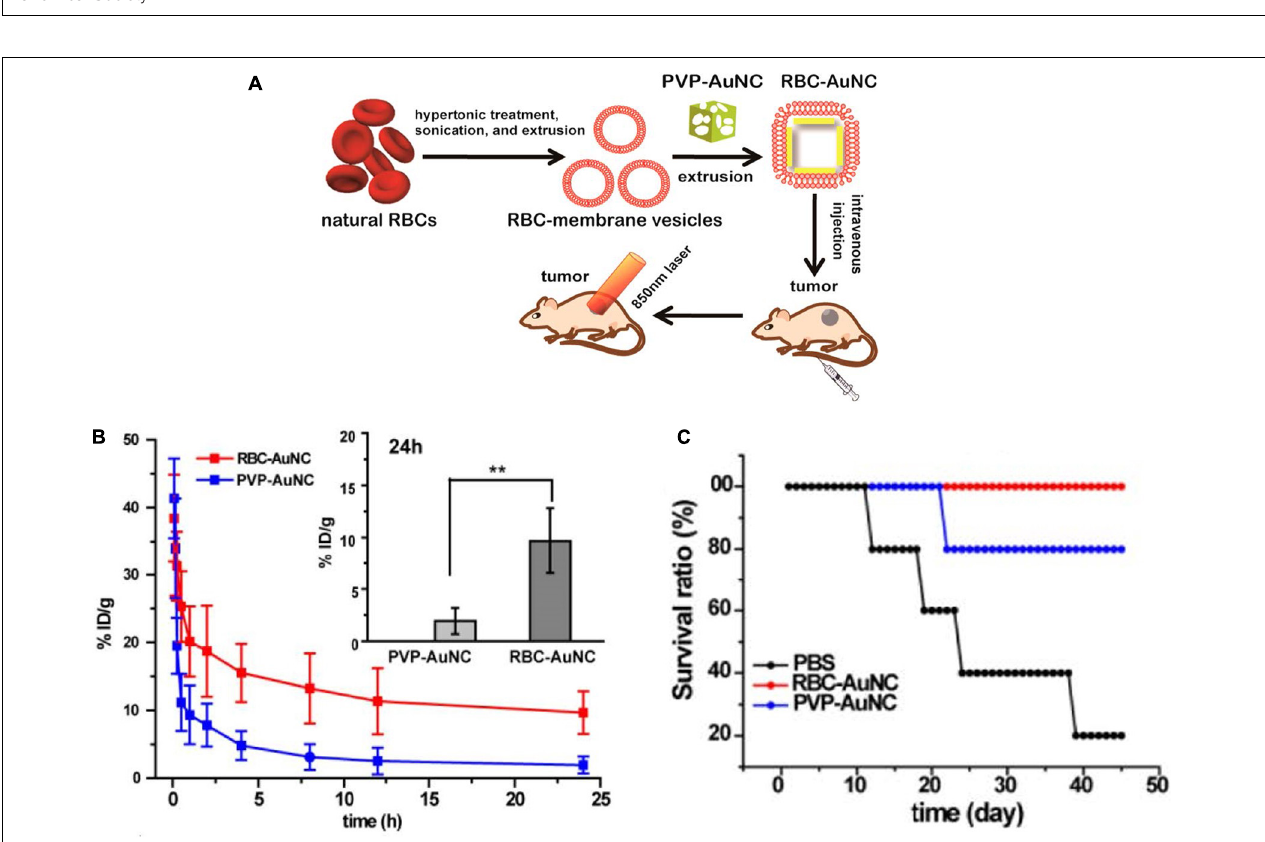
FIGURE 5 | Description of various strategies in colloidal plasmonic nanoparticle. Reprinted with permission from Kang et al. (2019), Copyright (2019) American Chemical Society.